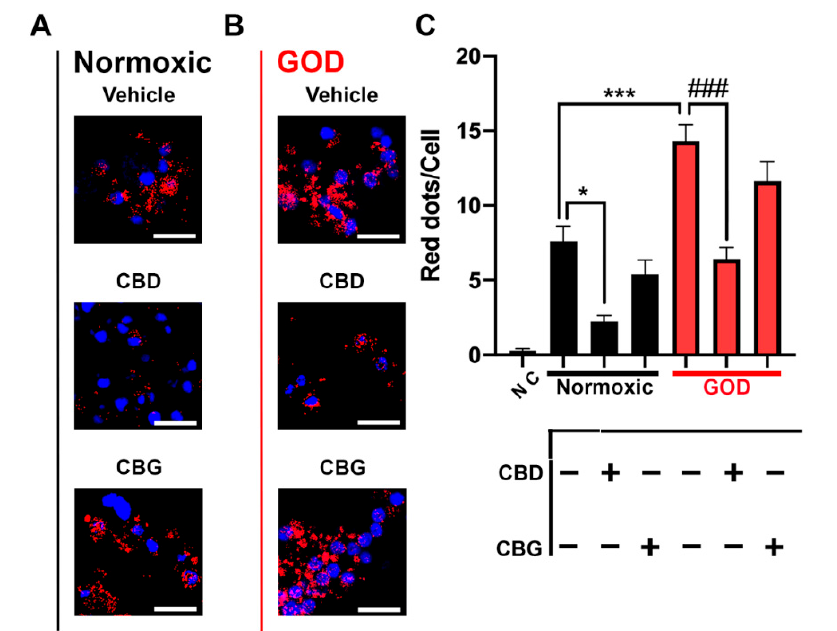
Figure 3. Effect of CBD and CBG on CB 2 –5HT 1A heteromer expression in GOD neurons. ( A , B ) CB 2 – 5HT 1A heteromers were detected by in situ proximity ligation assay (PLA) in primary striatal neurons. Neurons were treated with either 200 nM CBD, 200 nM CBG, or vehicle for 30 min. Thereafter, cells were deprived of glucose and oxygen (GOD) ( B ) or were kept in aerated complete medium ( A ) for 4 h. Experiments were performed in samples from 6 different animals. Confocal images (stacks of 3 consecutive panels) were analyzed for assessing the number of red dots/cell. Red dots indicate expression of heteromers. Hoechst-stained nuclei appear in blue. Scale bar: 10 µ m. ( C ) Quantification of the number of dots-clusters/cell was performed using the Andy’s algorithm Fiji’s plug-in. One-way ANOVA followed by Dunnett’s multiple comparison post hoc tests were used for statistical analysis. NC: negative control; * p < 0.05, *** p < 0.001 versus normoxic vehicle, ### p < 0.001 versus GOD vehicle.